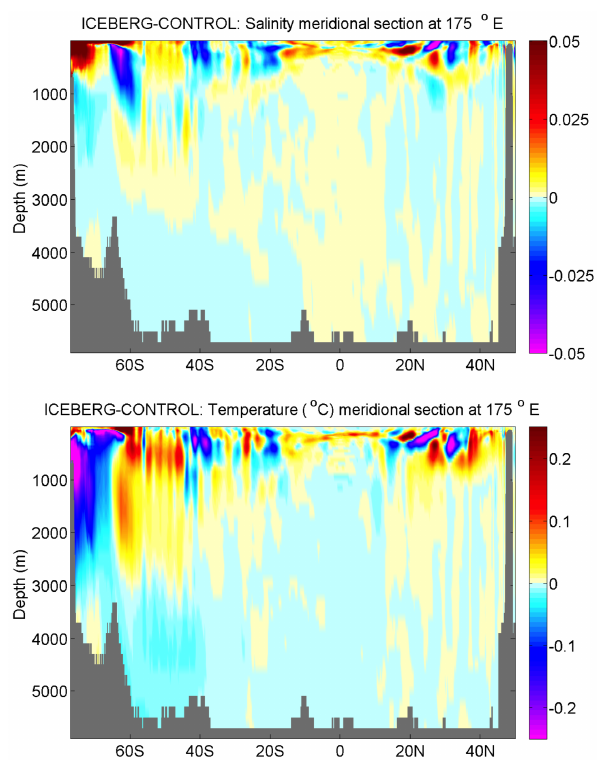
Figure 9. As Fig. 8, at 175 ◦